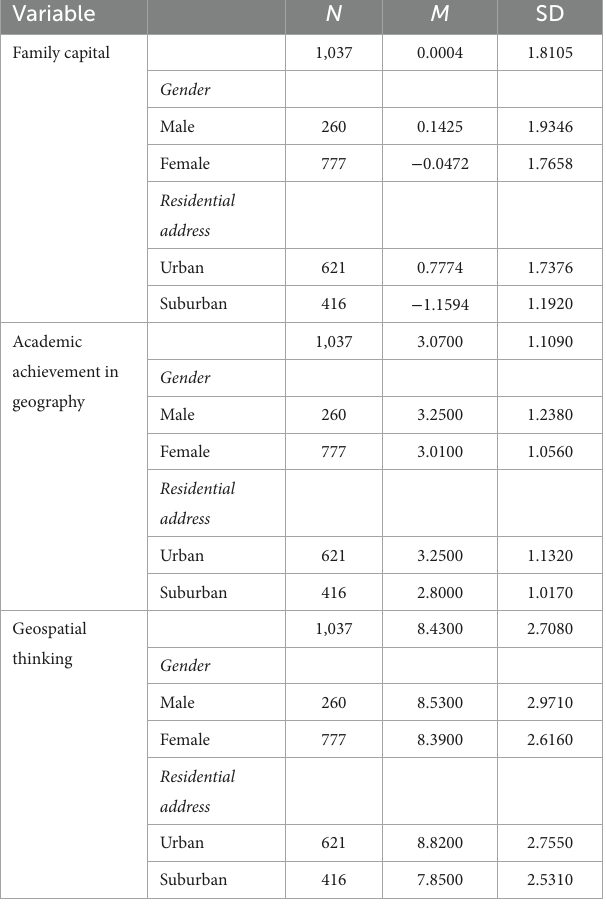
TABLE 1 Descriptive statistics for the three